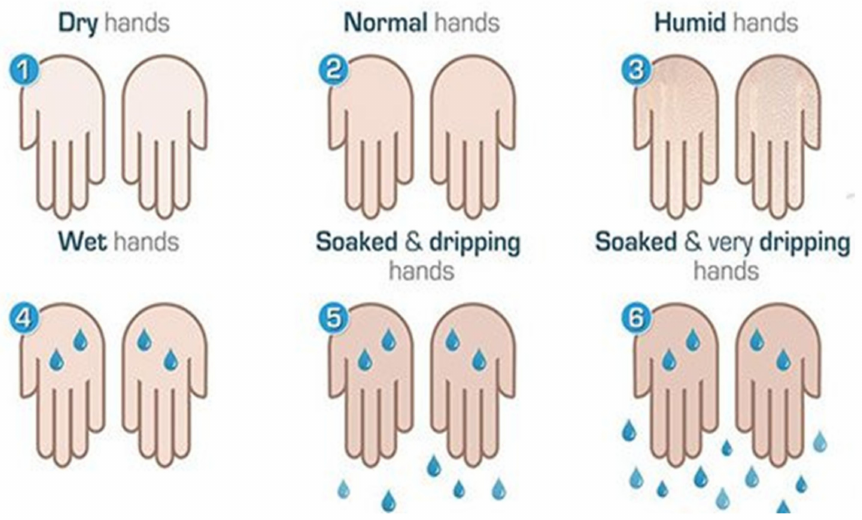
Figure 1. Visual scale for the quantification of palmar hyperhidrosis. Source: Lyra